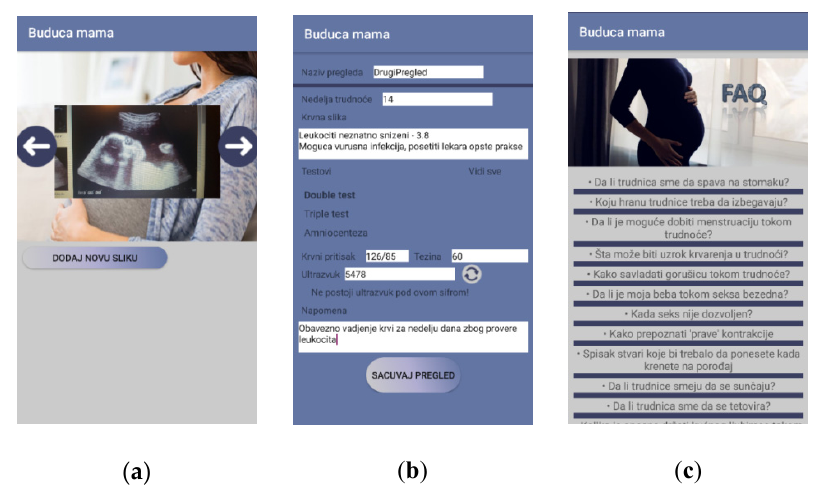
Figure 3 . ( a ) My profile; ( b ) Double test; ( c ) Enter daily parameters. Figure 3. ( a ) My profile; ( b ) Double test; ( c ) Enter daily parameters.